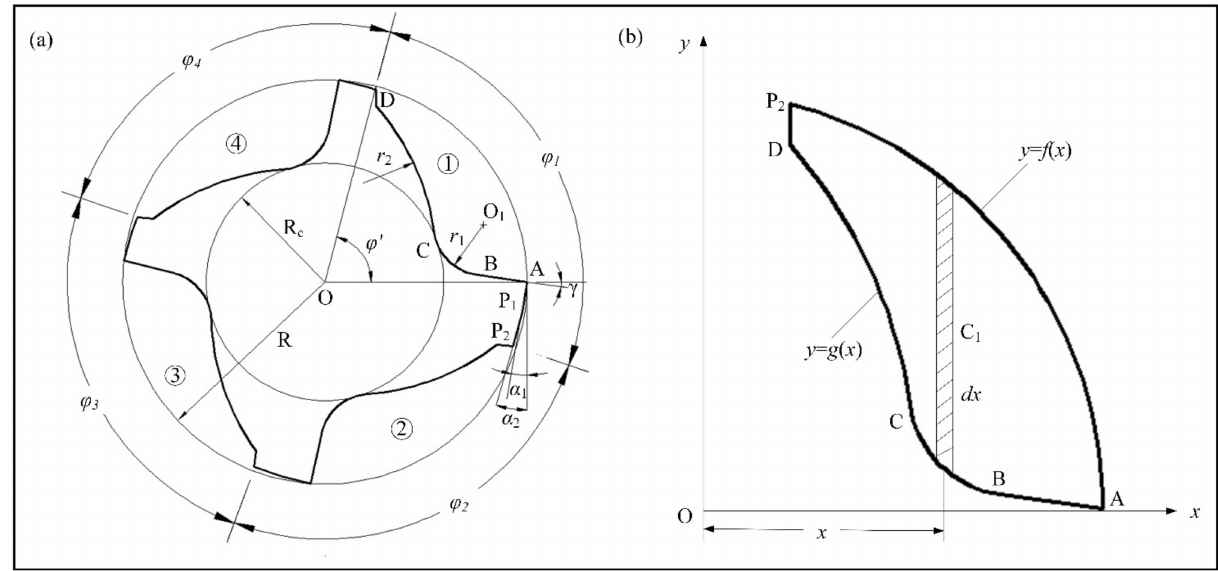
Figure 3. End section of variable-pitch end mill: ( a ) parameter characteristics with four flutes; ( b ) schematic of calculating centroid